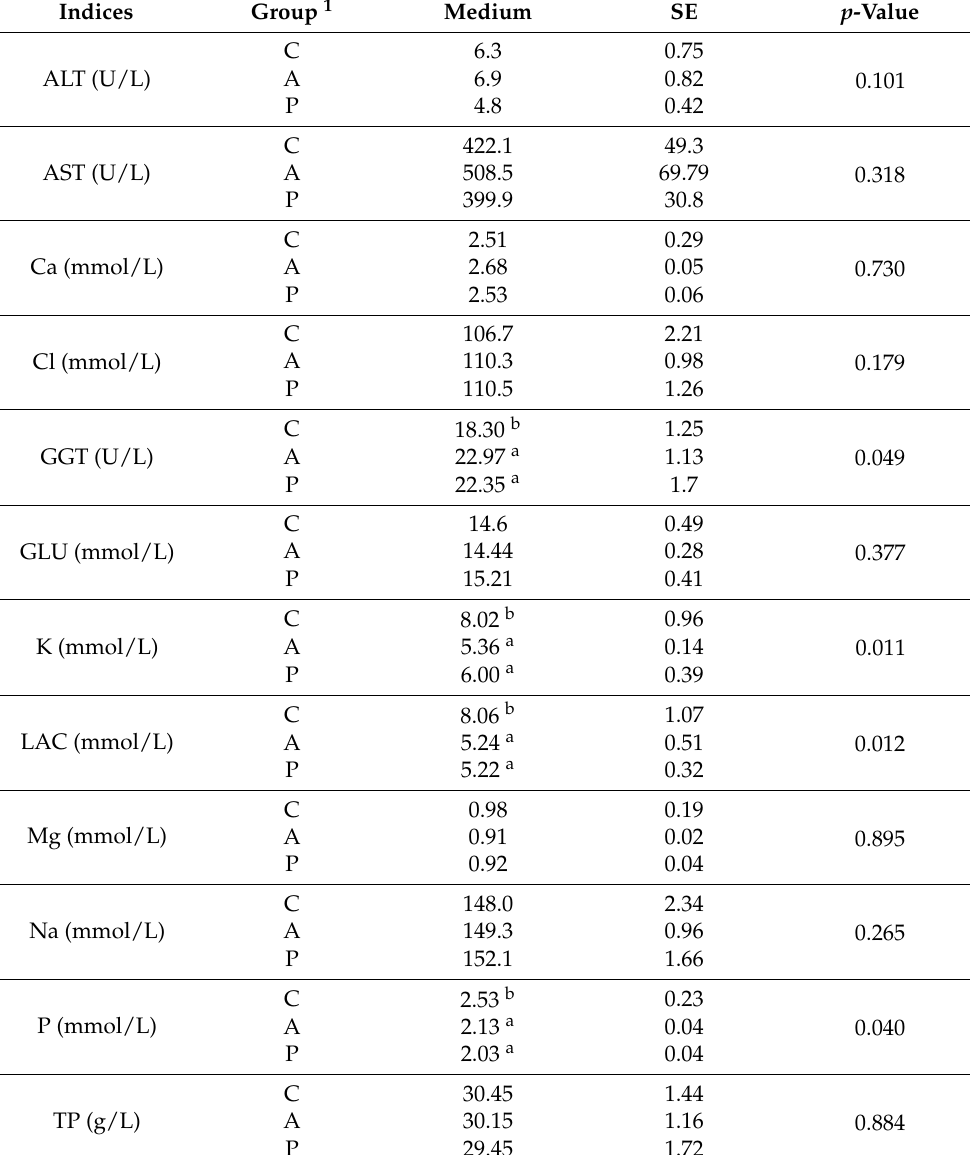
Table 4. Blood biochemical indices in 42-day-old chickens fed experimental diets ( n =